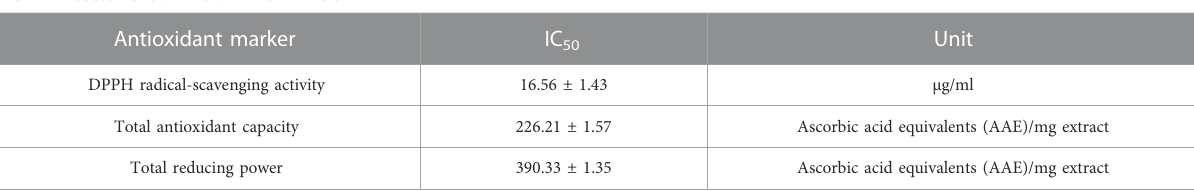
TABLE 4 Assessment of antioxidant